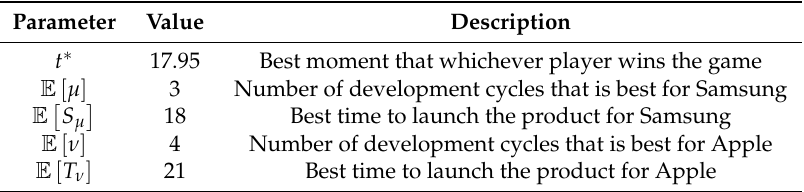
Table 3. Simulated results of the